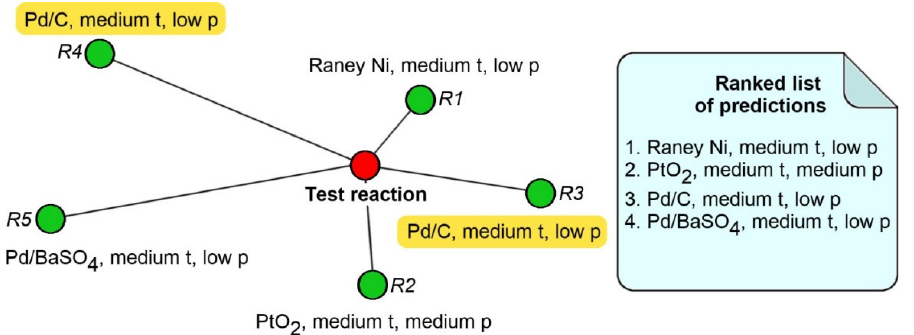
Figure 8. Conditions prediction by the k Nearest Neighbors approach. Note that the conditions are the same for reactions R3 and R4, thus conditions combination for more distant reaction R4 was ignored.